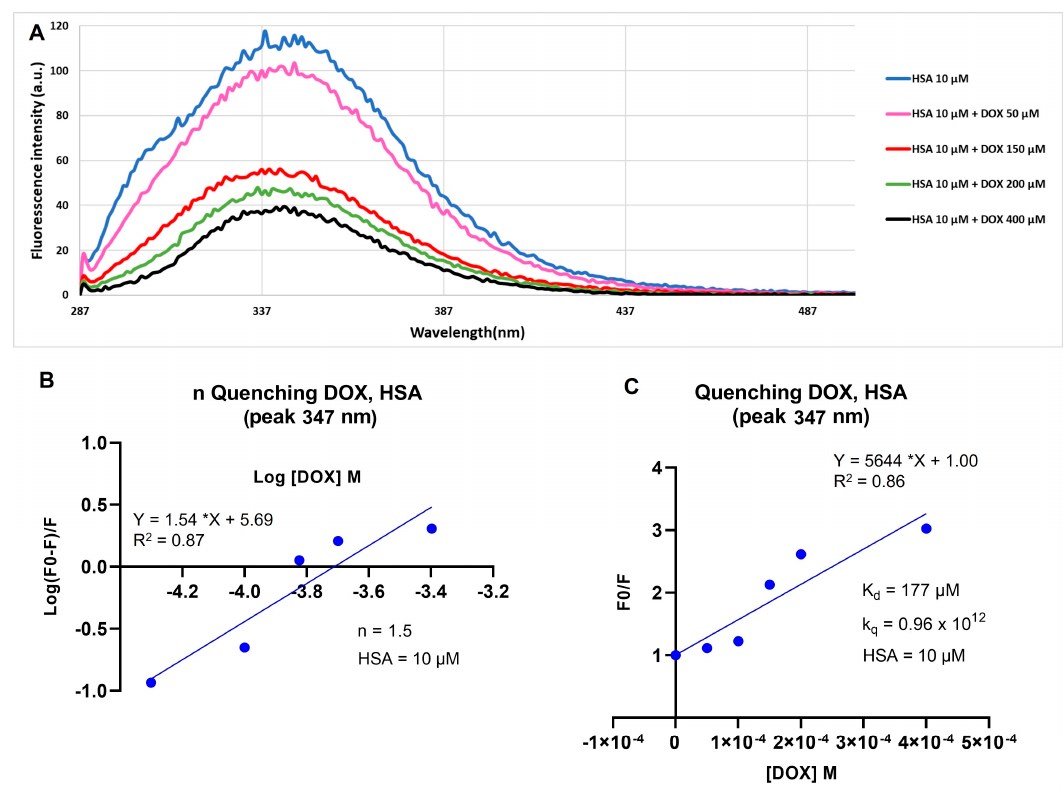
Figure 1. Fluorescence emission spectra and Stern–Volmer plots for HAS–doxorubicin interaction. ( A ) Fluorescence emission spectra; ( B ) Stern–Volmer plot of HSA binding sites; ( C ) Stern–Volmer plot of K d and k q . p <